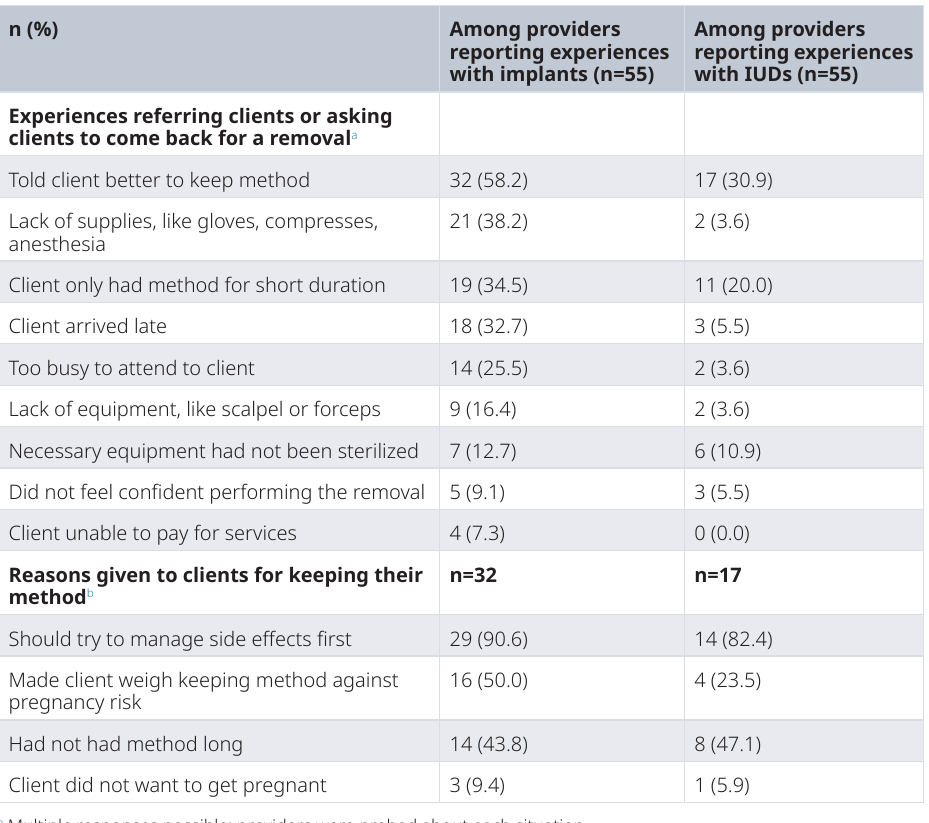
Table 3. Experiences referring or asking clients to come back for removals among all providers, by